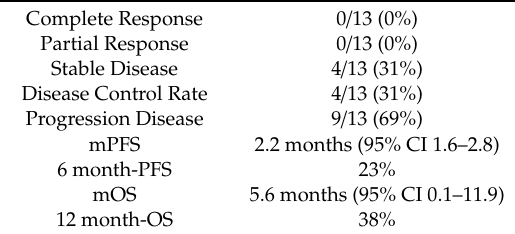
Table 3. Pembrolizumab activity.